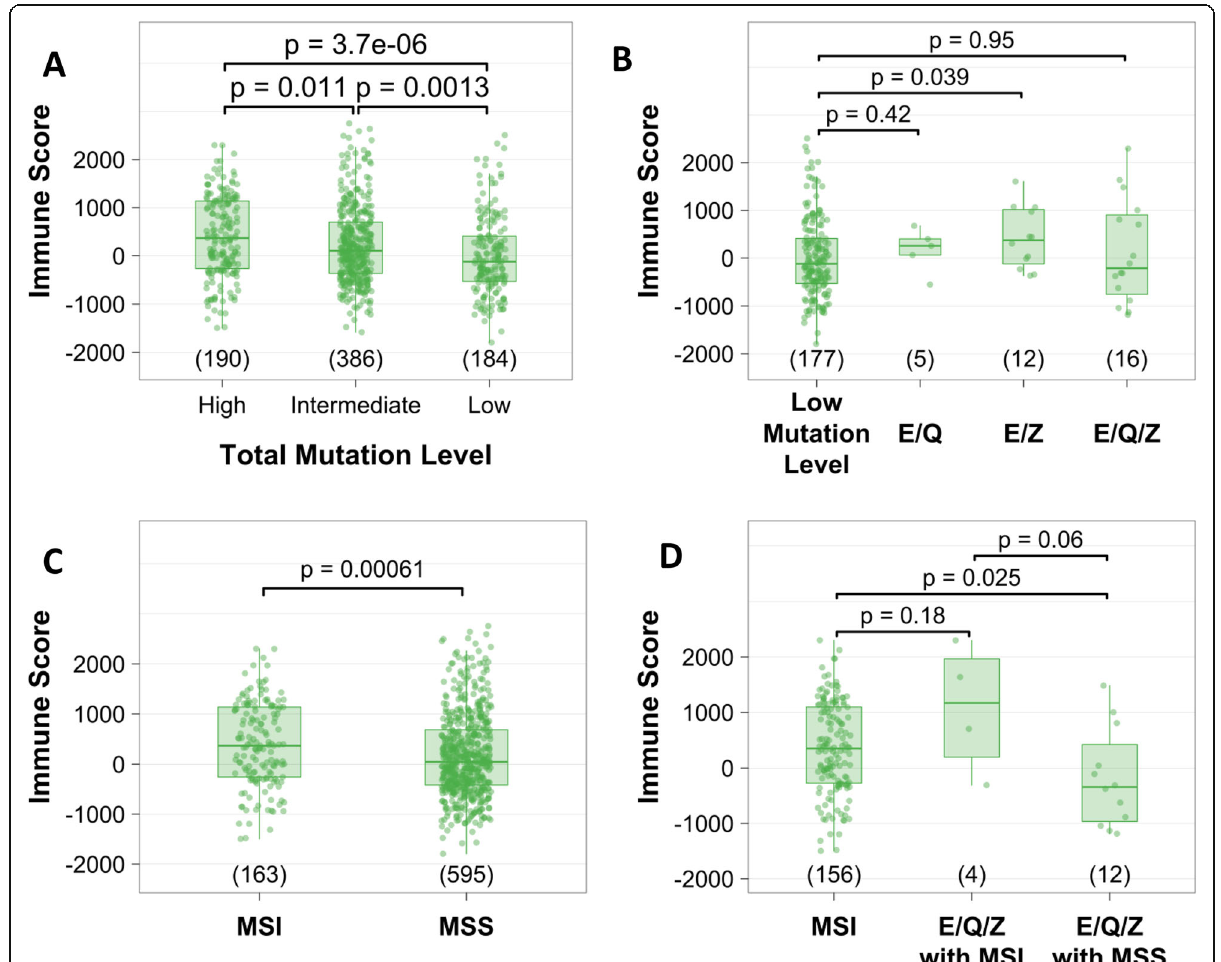
Fig. 4 ESTIMATE immune scores by mutation frequency quartiles, E/Q/Z mutation groups, and MSI in colorectal [38] , endometrial (UCEC) and stomach (STAD) cancers . a ESTIMATE immune scores in cancers within high, intermediate and low overall mutation quartiles. b Immune scores of samples with E/Q , E/Z and E/Q/Z mutations compared to the low mutation quartile from panel A. c Immune scores in groups of cancers separated by MSI status. d Immune scores in MSI and MSS E/Q/Z cases compared to all other MSI cases. For each panel the number of cases within each group is included in parentheses on the